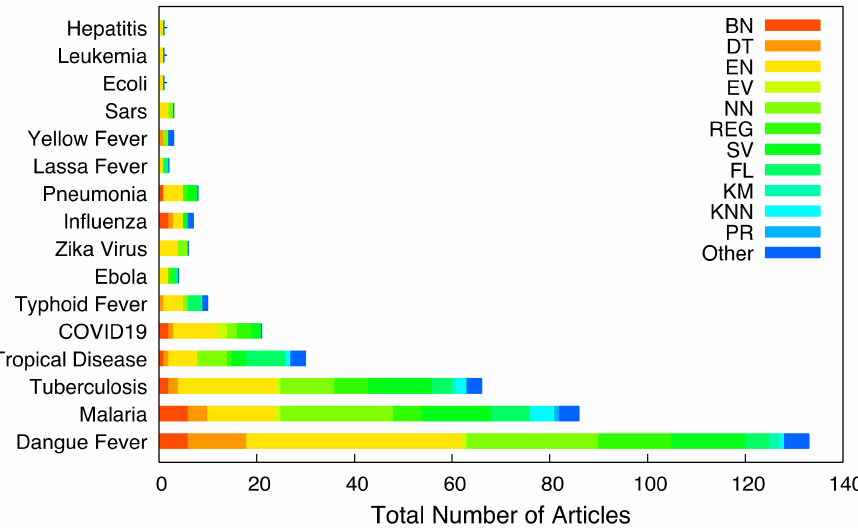
Figure 6. Algorithms distribution for each disease.